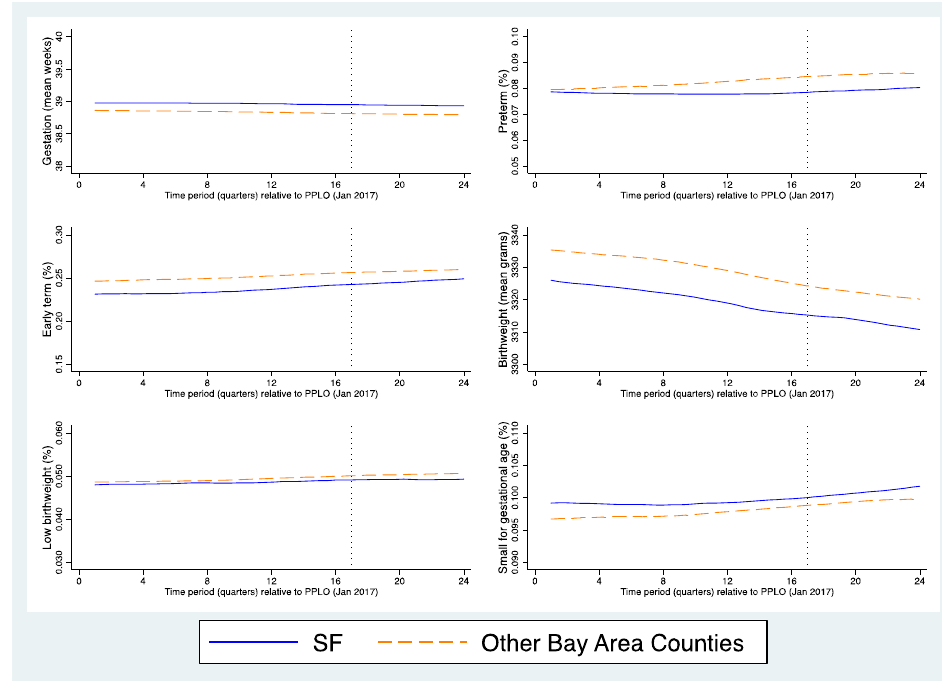
Figure 2. Visual inspection of pre-policy trends for perinatal outcomes.